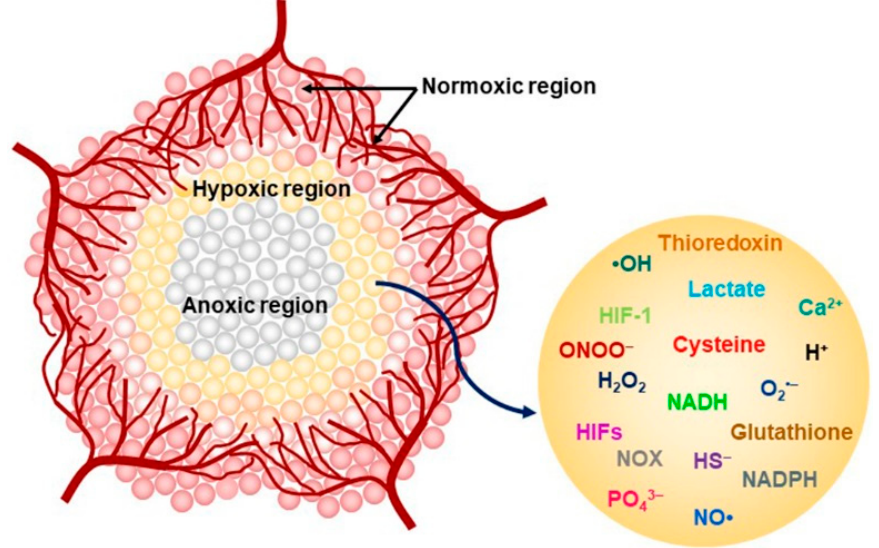
Figure 1. Schematic representation of regions of a tumor ( left ) and chemicals that are overproduced in hypoxic regions ( right ).